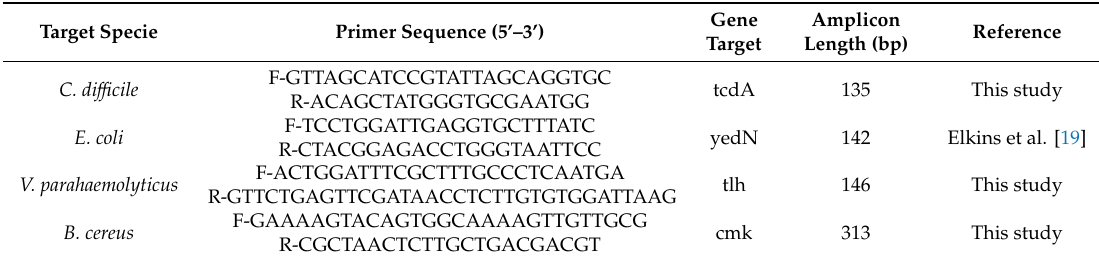
Table 2. Primer sequences used to amplify each